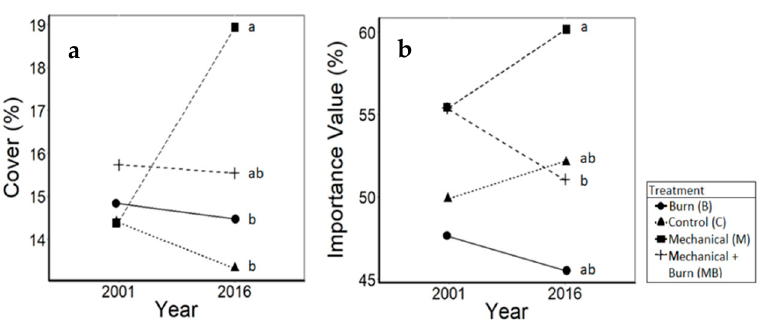
Figure 8. Shrub primary guild ( a ) absolute cover (%) and ( b ) importance value results showing the 4 treatment effects (control = C, burned = B, mechanical removal of stems <10 cm in diameter at breast height (DBH) = M, and mechanical removal of stems <10 cm DBH + burned = MB) from 3 analysis of variance (ANOVA). Post ‐ hoc comparison (Tukey’s Honest Significant Difference Test, THSD) letters show differences between treatment effects from 2001 to 2016.